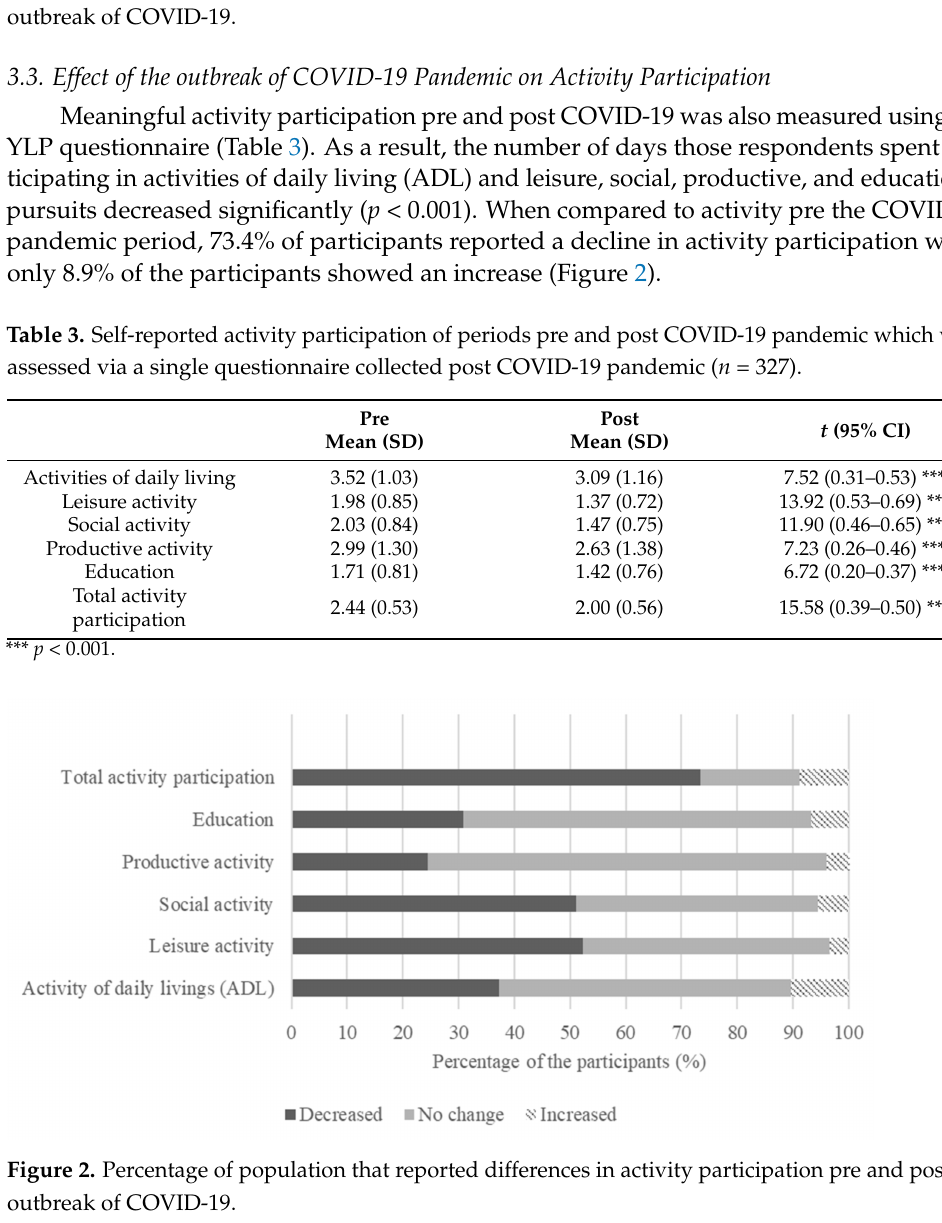
Figure 1. Percentage of population that reported differences in physical activity pre and post the outbreak of COVID-19.